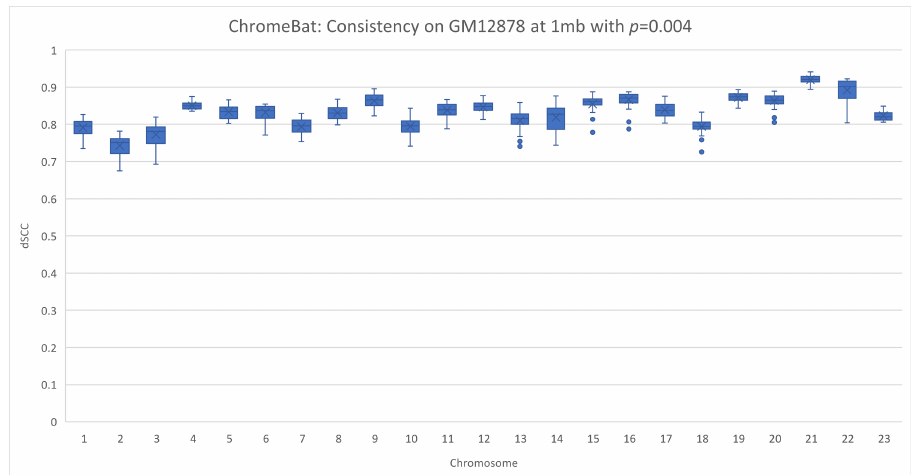
Figure 13. Consistency of ChromeBat on GM12878 with p = 0.004. This is a consistency experiment done on GM12878 where hyperparameters from Figure 4 with the exception of the number of structures, structs , is 35 and p =